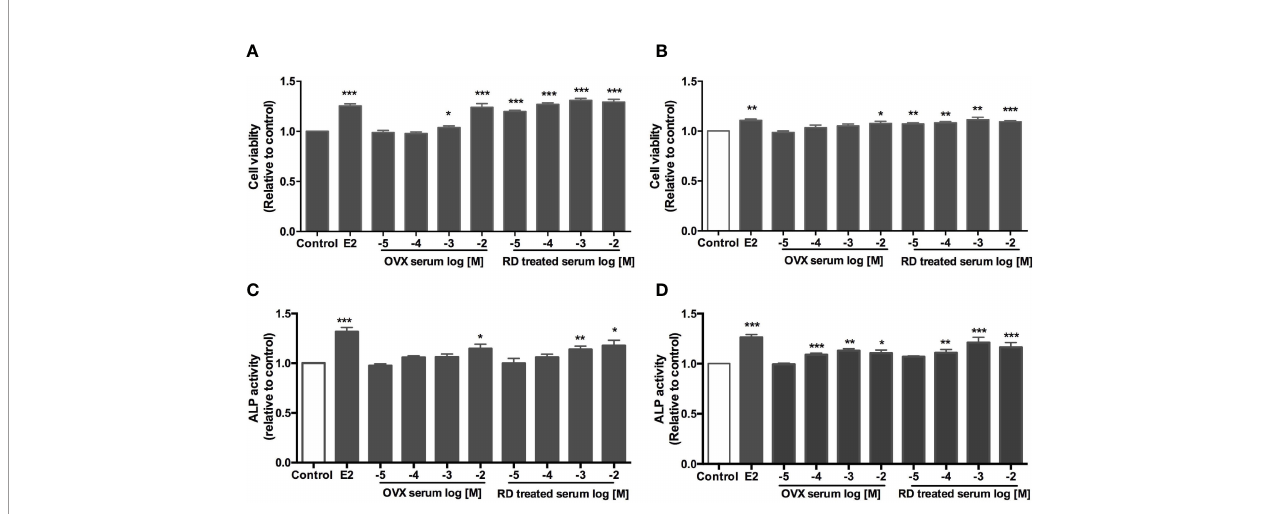
FIGURE 6 | Direct estrogenic effects of OVX serum or RD-treated serum in ER-positive cells. Human breast cancer MCF-7 (A) neuroblastoma SHSY5Y (B) endometrial cancer Ishikawa (C) and osteosarcoma MG-63 cells (D) were treated with E2 (10 nM), OVX serum (10 − 5 – 10 − 2 dilution) or RD-treated serum (10 − 5 – 10 − 2 dilution) for 48 h. MTS assays were performed in MCF-7 and SH-SY5Y cells while ALP activities were measured in MG-63 cells and Ishikawa cells. Results were expressed as ratio to control. n = 3 or more. * p < 0.05, ** p < 0.01, *** p < 0.001 vs.